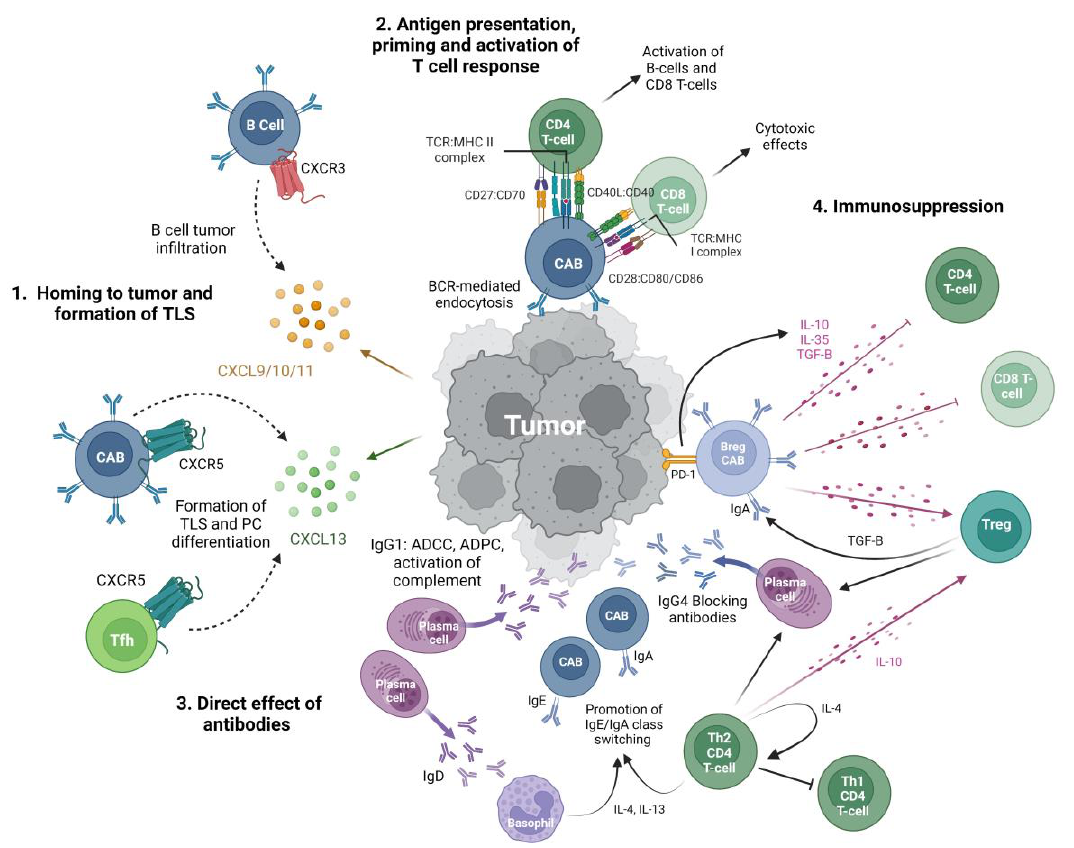
Figure 1. Putative effector functions of B cells in sarcoma. 1. Homing to tumor and formation of TLS: increased expression of CXCR3 in intra-tumoral B cells suggests homing to tumor via CXCR3:CXCL9/10/11 pathways [11,19]. Increased CXCL13 in the tumor microenvironment pro- motes the homing of B cells and follicular T helper cells via CXCR5 and formation of TLS [20]. 2. Antigen presentation, priming and activating T cell response: B cells act as professional APCs that use BCR-mediated endocytosis to process and present tumor antigens via MHC class I and II molecules to T cells [21,22]. Relatively high levels of expression of costimulatory molecules CD27, CD80, and CD86 suggest intra-tumoral B cells are potent T cell stimulators which have downstream anti-tumor effects [11,23,24]. 3. Direct effects of antibodies: differentiation of B cells into plasma cells generates antibodies with a variety of effector functions. IgG1 can opsonize tumor cells for antibody-dependent phagocytosis, antibody-dependent cellular cytotoxicity, and activation of the complement [25]. IgG4 has been hypothesized to act as a blocking antibody and inhibit IgG1 activity and is promoted by T regs and Th2 CD4 + T cells [26]. IgA may act via Fc receptor-mediated effector func- tions such as IgG1, however, IgA-positive B cells also participate in a positive feedback loop with immunosuppressive T regs , as TGF- secreted by T regs promotes IgA class switching and IgA + B regs secrete IL-10 and IL-35 [27]. IgD promotes class switching towards IgA and IgE via basophil activa- tion. High IgE reflects increased Th2 differentiation of CD4 + T cells and limited differentiation to- wards Th1 with decreased anti-tumor, cell-mediated responses [27]. 4. Immunosuppression: B regs may promote tumor growth by secretion of immunosuppressive cytokines that downregulate T cell effector functions and promote T reg differentiation and proliferation. B regs are IgA + and can express PD-1, which acts to promote IL-10 production [27,28]. This may have implications for use of immune checkpoint inhibition in sarcoma treatment [28 – 31]. Abbreviations: CAB: cancer associated B cell; B reg : regulatory B cell; T reg : regulatory T cell; APC: antigen presenting cell; Tfh: T follicular helper